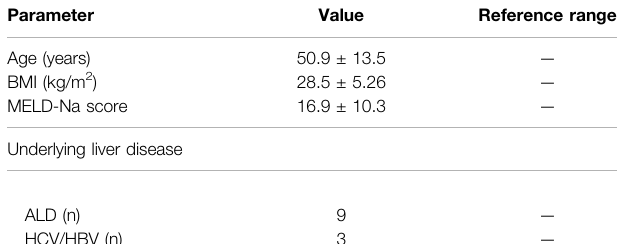
TABLE 1 | Clinical characteristics of study group before orthotopic liver transplantation (mean ± SD). Parameter